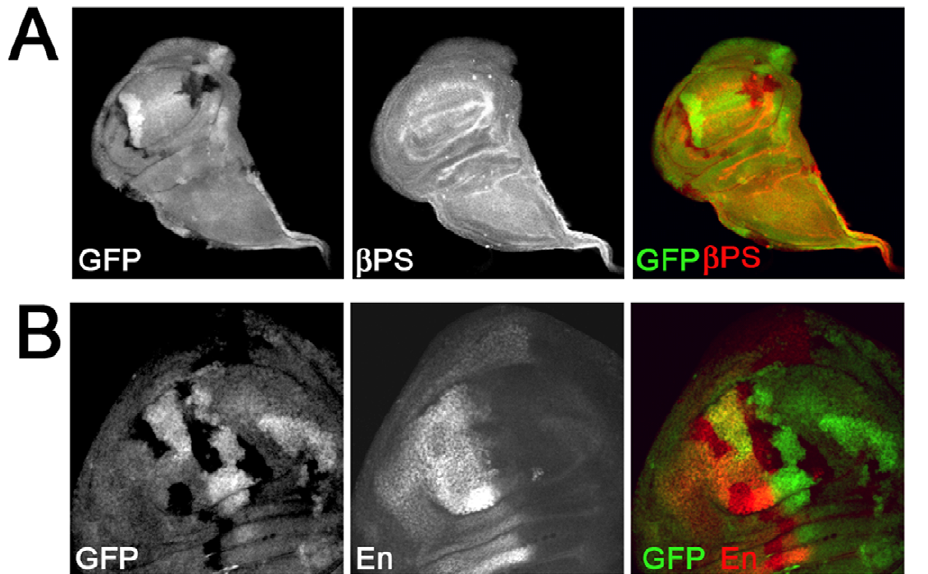
Figure 3. Asx mutation has no effect on b PS integrin or Engrailed expression. Wing discs bearing Asx mutant clones (lacking GFP, green) were immunostained with anti- b PS (A) or anti-Engrailed (B) antibodies.